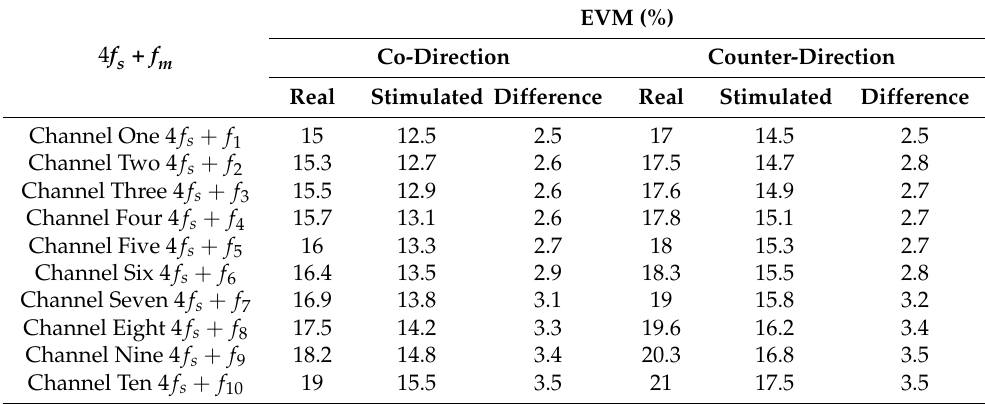
Table 4. Real and stimulated EVMs of the ten mixed signals in co- and counter-direction schemas at 4 f s + f m at the bit rate of 100 Gbit/s.